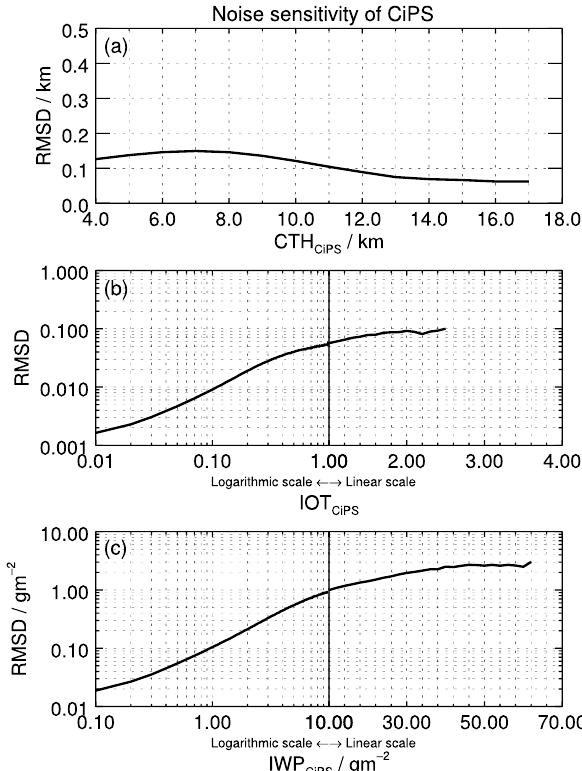
Figure 11. The noise sensitivity of the CTH CiPS (a) , IOT CiPS (b) and IWP CiPS (c) retrievals. The noise sensitivity is reported as the RMSD between the CiPS standard retrieval and 100 retrievals where the SEVIRI input data are randomly perturbed within the ra- diometric noise range of